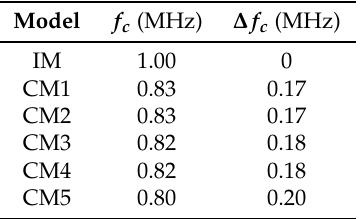
Table 3. Centroid frequency ( f c ) of half-power contour for all